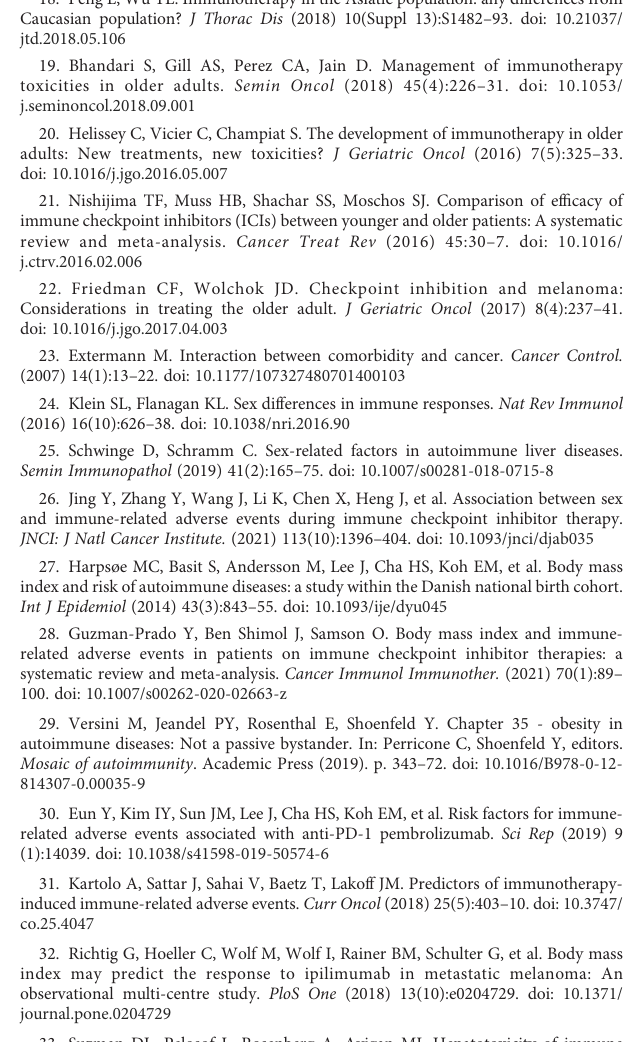
SUPPLEMENTARY TABLE 2 Results of the IPD meta-analysis for the demographic factors used as confounders in the model for each risk factor. This IPD meta-analysis model included the following fi xed effects: sex (female vs male), BMI (kg/